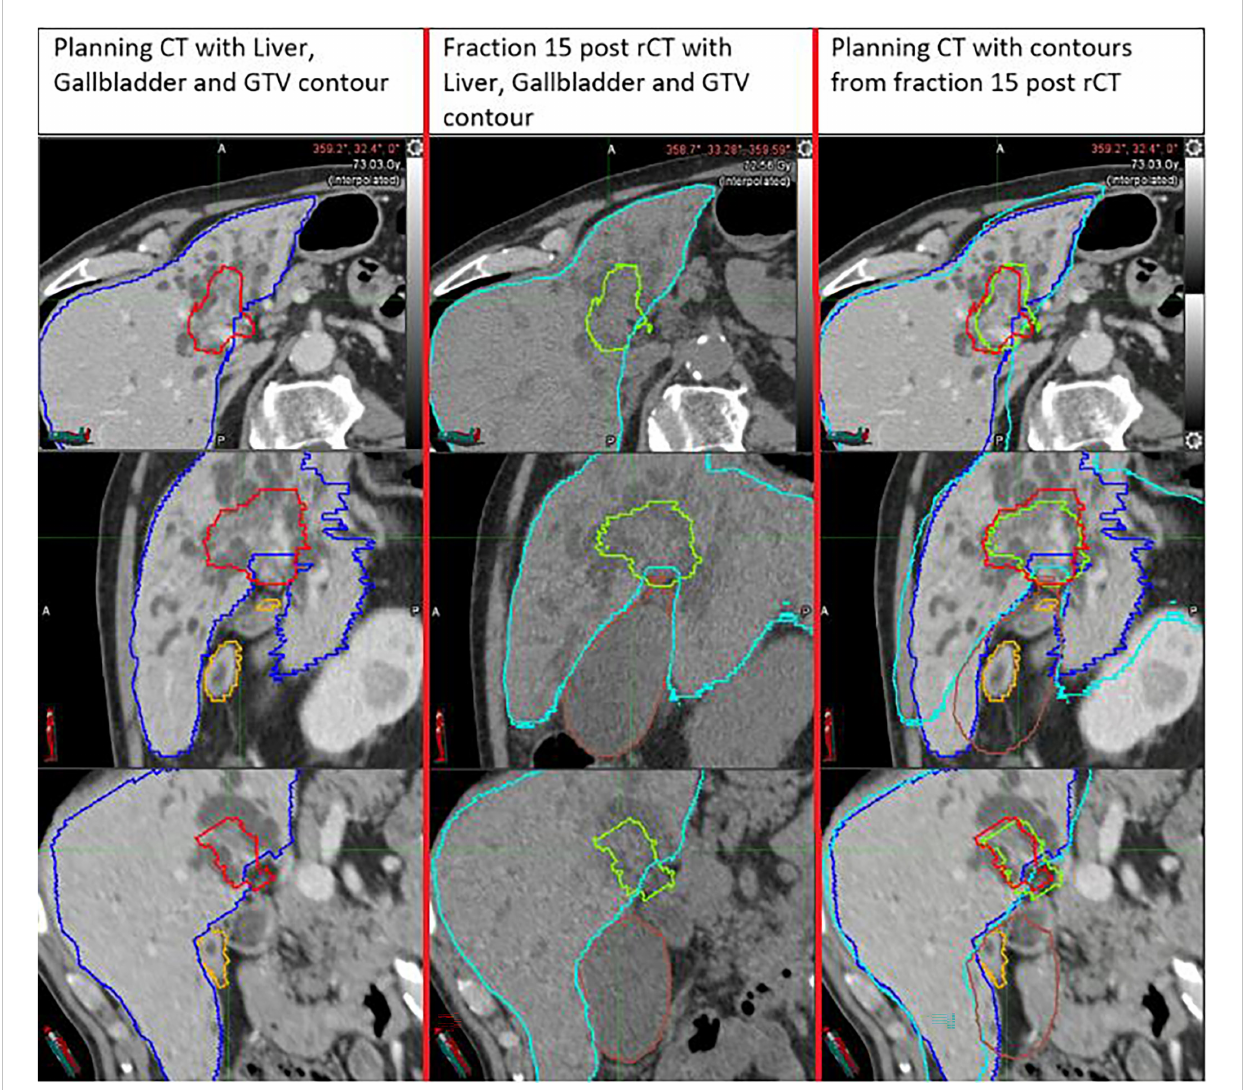
FIGURE 3 Example of a large PTV coverage loss (17.7%) in the post-rCT of the last fraction of patient 5, compared to pCT. The increased gallbladder volume pushed the fi ducial away from the target, leading to less ef fi cient tracking and considerable underdosage of the